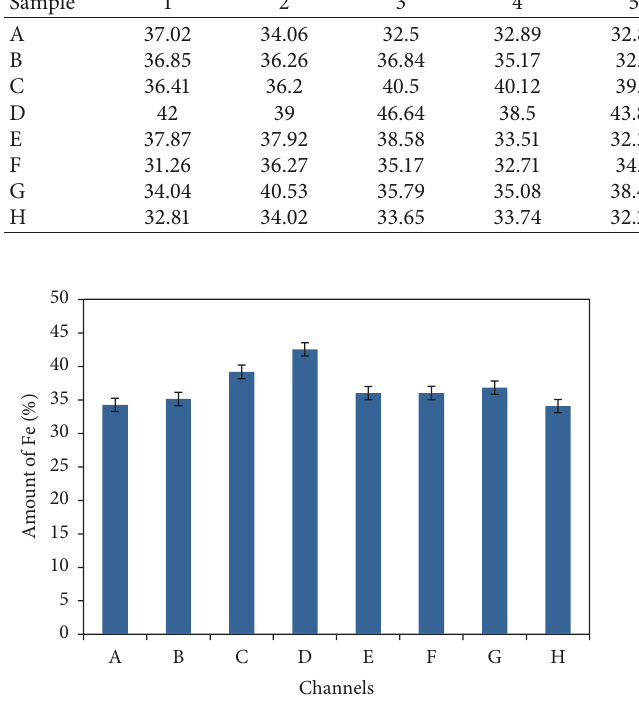
Figure 4: Average percentage of Fe content in hematite ore of Pokhari determined titrimetrically. Samples were collected from eight channels and each channel consists of nine samples. The values shown here are the average of these nine samples of each channel. The channels are arbitrarily graded from A to H.